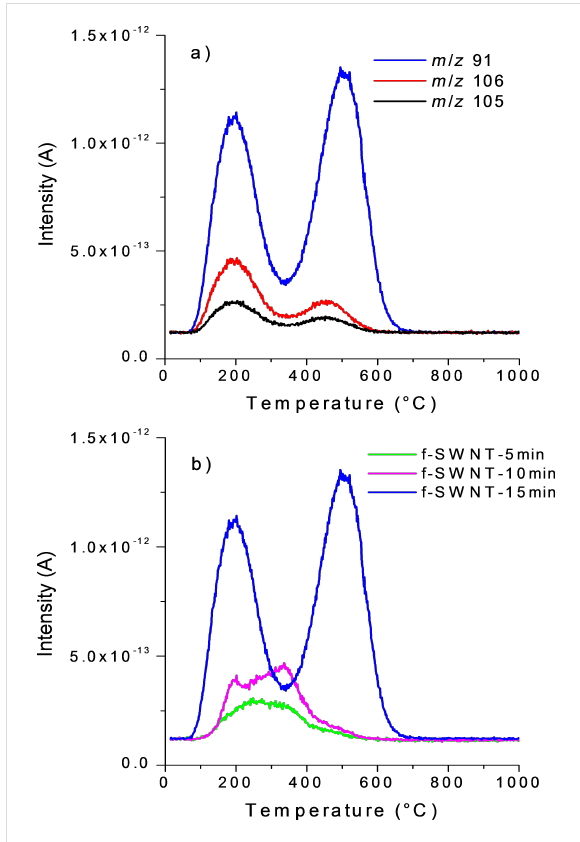
Figure 5: Mass spectrometry intensities for xylene. a) main m / z of xylene for f-SWNT-15min, b) m / z 91 for f-SWNT-5min (pink curve), f-SWNT-10min (green curve), and f-SWNT-15min (blue curve).